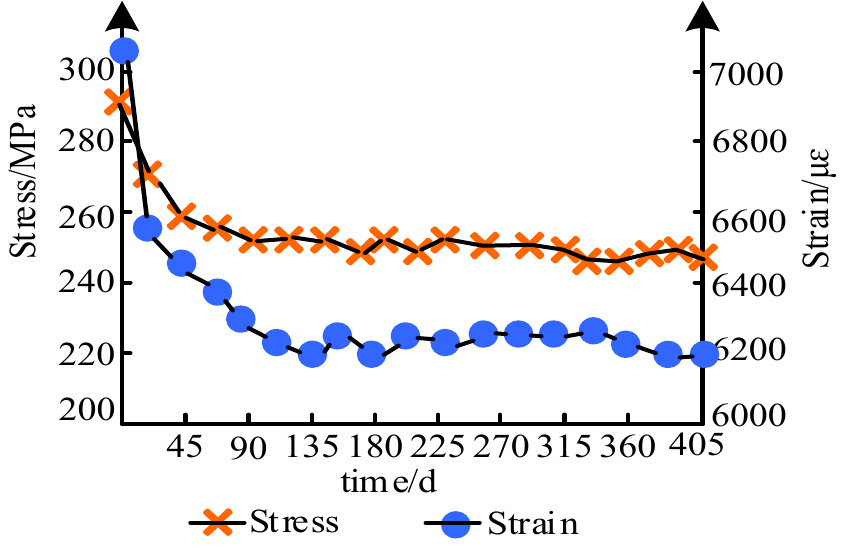
Figure 4. Stress–strain progress of the bolt rod body of specimen A. According to the changes instrain and stress in Figure 4, the stress–strain curve of the anchor rod body at anytime can beobtained. Figure 4 shows that the most effective duration of the strain attenuation process was 225 d. This is because the solution erosion affected the synchronization effect between the grating sensor and the rod body, and the strain data were distorted for a longer period of time. For the three specimens, the strain data of the anchor rod body in water exhibited a lower degree of distortion. The stress–strain curve of the bolt specimen is shown in Figure